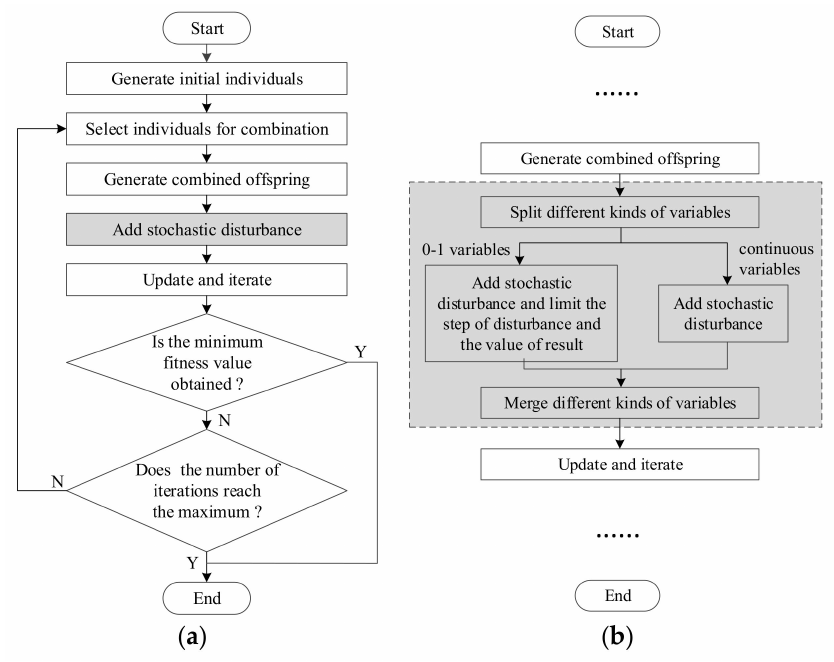
Figure 4. ( a ) Flow chart of BSO; ( b ) IBSO with variable splitting and disturbance